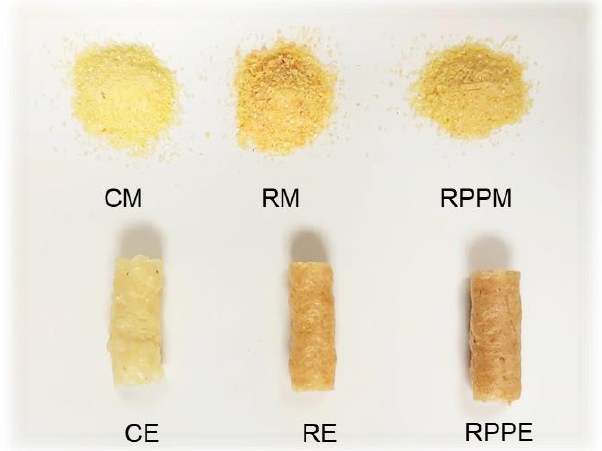
Table 3. Mean values (and standard deviations) of color coordinates ( L* , a* , b* , C* , and h* ) and total color differences ( ∆ E) of the corn mixtures and extrudates. For each parameter, the same superscript small letter within rows indicates homogeneous groups established using ANOVA ( p < 0.05) compared to samples in mixtures or extrudates. For each sample and parameter, the same capital letter in superscript within rows indicate homogeneous groups established using ANOVA ( p < 0.05) compared to mixtures and extrudates. Samples were mixtures (M) and extrudates (E). C: control, R: rosehip enrichment, and RPP: rosehip + pea protein enrichment. L* (lightness), a* (red/green coordinate), b* (yellow/blue coordinate), C* (chroma), and h* (tone).